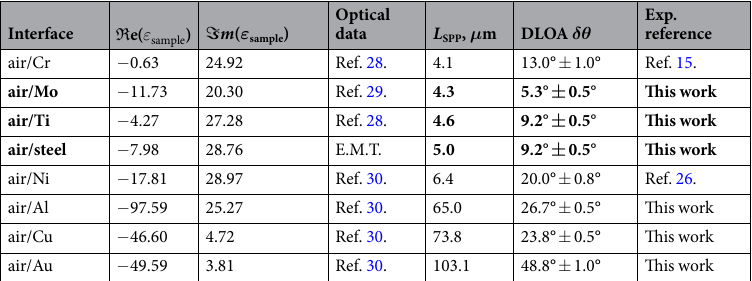
This work Table 2. Properties of excitable SPPs at several air-metal interfaces upon laser irradiation at λ = 1030 nm. DLOA δθ determination is detailed in Materials and Methods. E.M.T. denotes the effective medium theory (the Lorentz-Lorenz formula 49 was used to calculate the dielectric permittivity of steel as function of the volume fraction of Fe, Ni and Cr contained in the sample). The parameters of HR-LIPSS fabricated in this work are highlighted as in Table